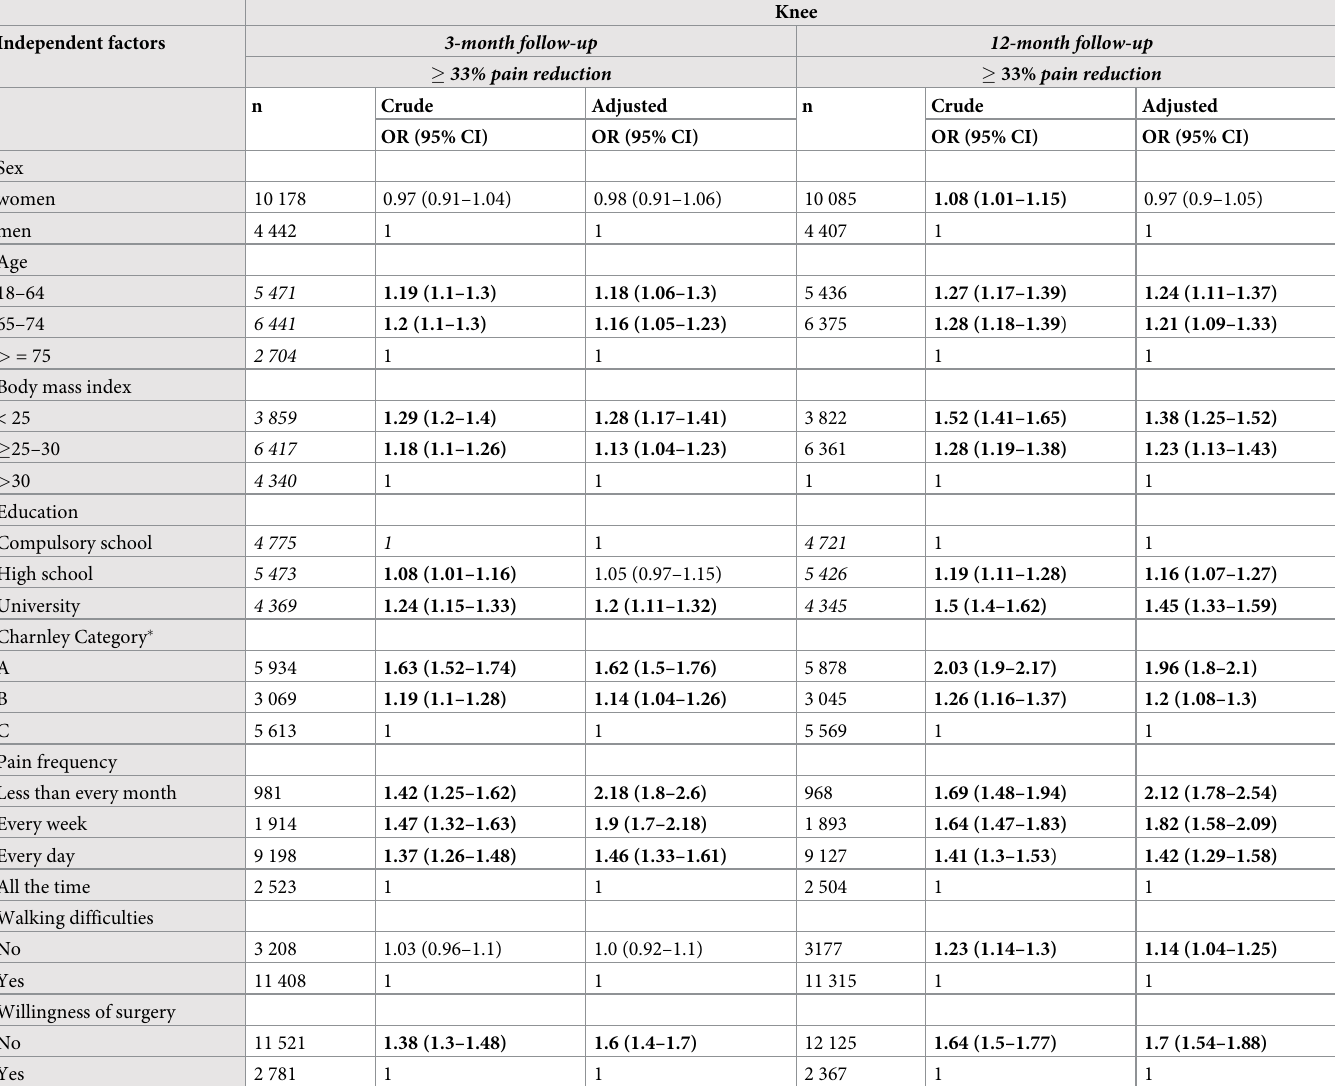
Table 3. Factors associated with reaching a clinically relevant pain reduction at 3- and 12-month follow-up in people with knee